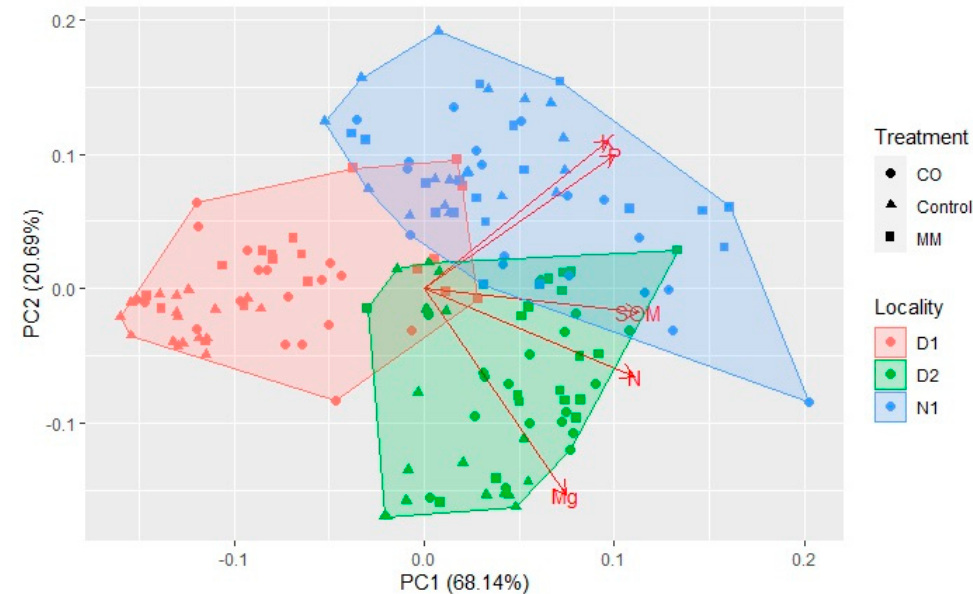
Figure 6. Multiparametric differences among Locality (D1, D2, and N1) and among Treatments (Control, CO, and MM) according to PCA analysis. The different colors identified the Locality, and the different shapes identify the Treatment within each experimental site. The biplot showed the correlations among the variables (SOM, N, Mg, P, and K).